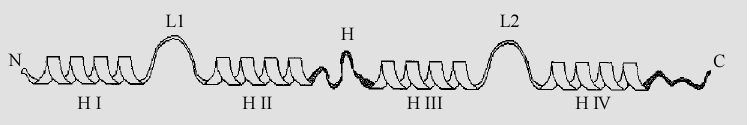
Figure 2 - Schematic representation of the secondary structure of an S100 protein. Each Ca 2+ -binding loop (L1 and L2, in the N- and the C-terminal half, respectively) is flanked by a - helices (helices I and II, and helices III and IV for L1 and L2, respectively). A linker region (hinge region, H) connects helix II to helix III. Helix IV is followed by a C-terminal extension. The hinge region and the C-terminal extension (in black) display the least amount of sequence homology among the S100 members (see Refs.